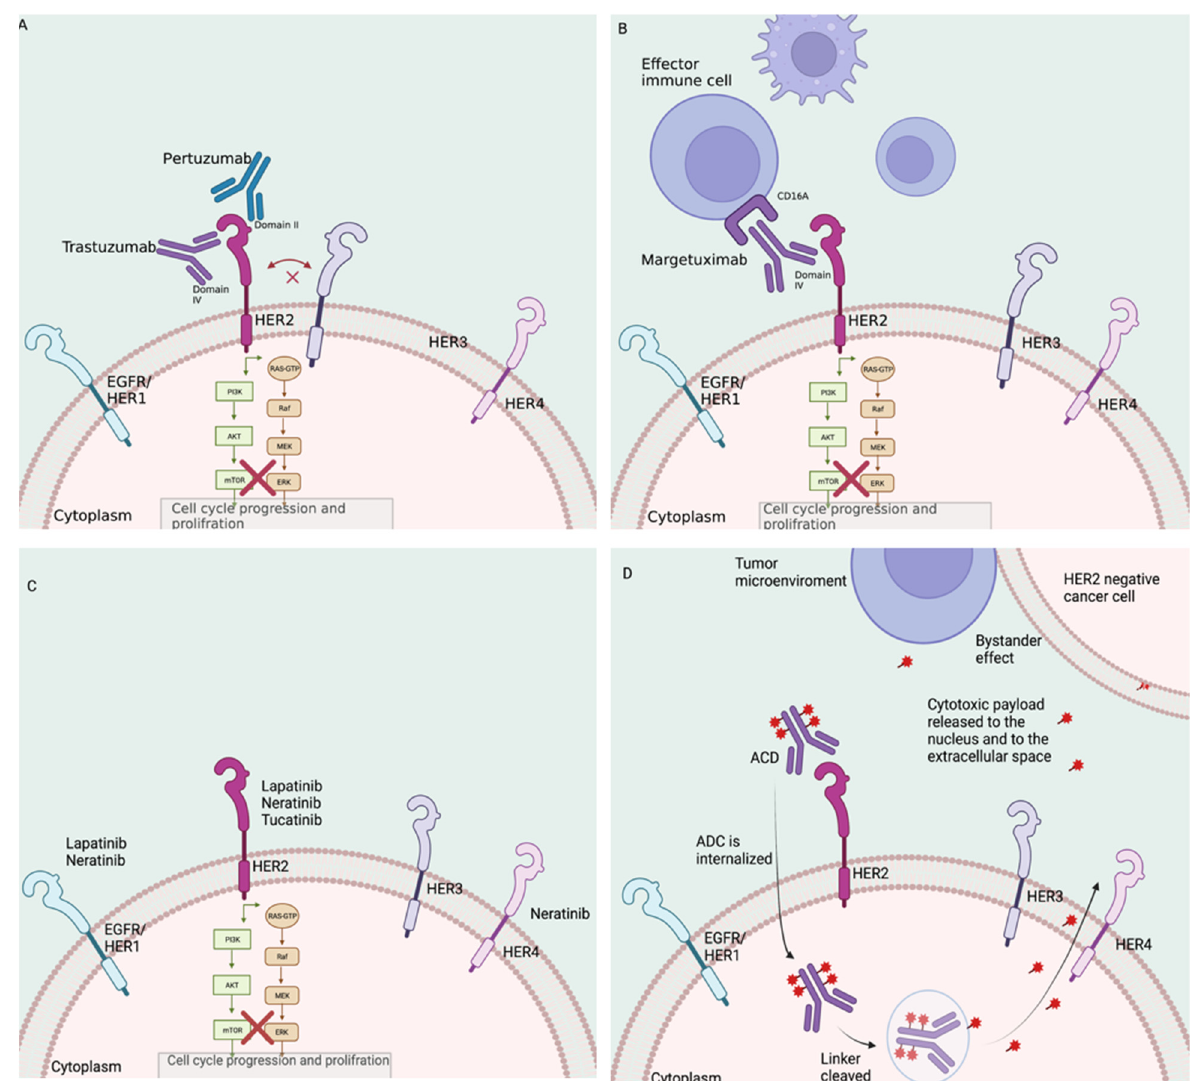
Figure 1. Mechanism of action of HER2-targeted therapies. Legend: ( A ) mechanism of action of trastuzumab and pertuzumab; ( B ) mechanism of action of margetuximab; ( C ) mechanism of action of tyrosine kinase inhibitors; ( D ) mechanism of actions of antibody-drug conjugates with a cleavable linker (Created with BioRender).